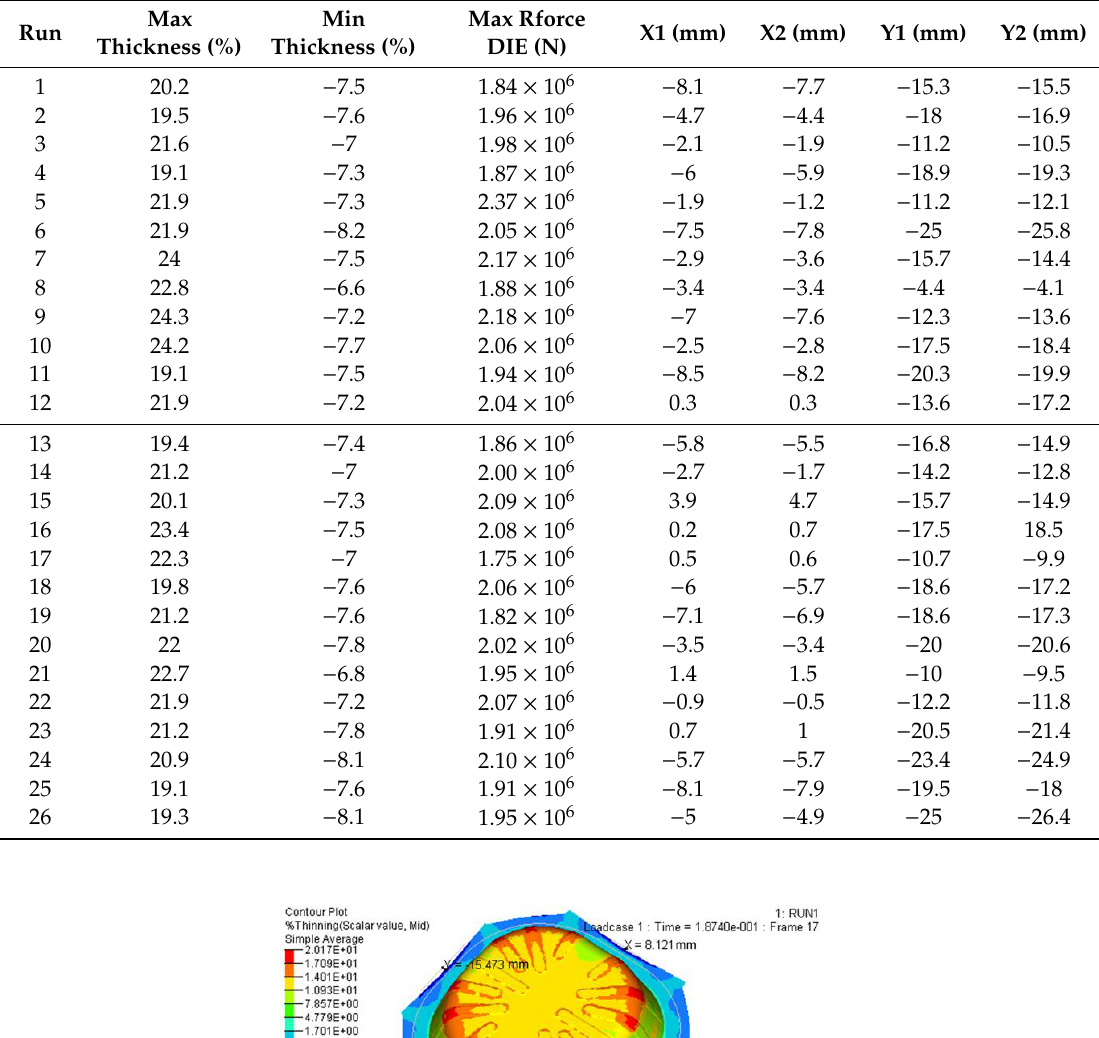
Table 5. Output of BLANK 1 simulation plan.